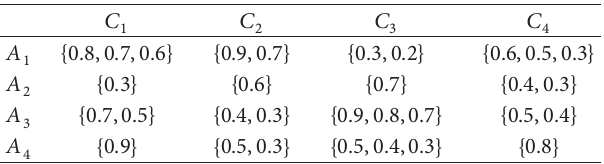
Table 2: The hesitant fuzzy decision matrix R 2 provided by decision maker 𝐷 2 .